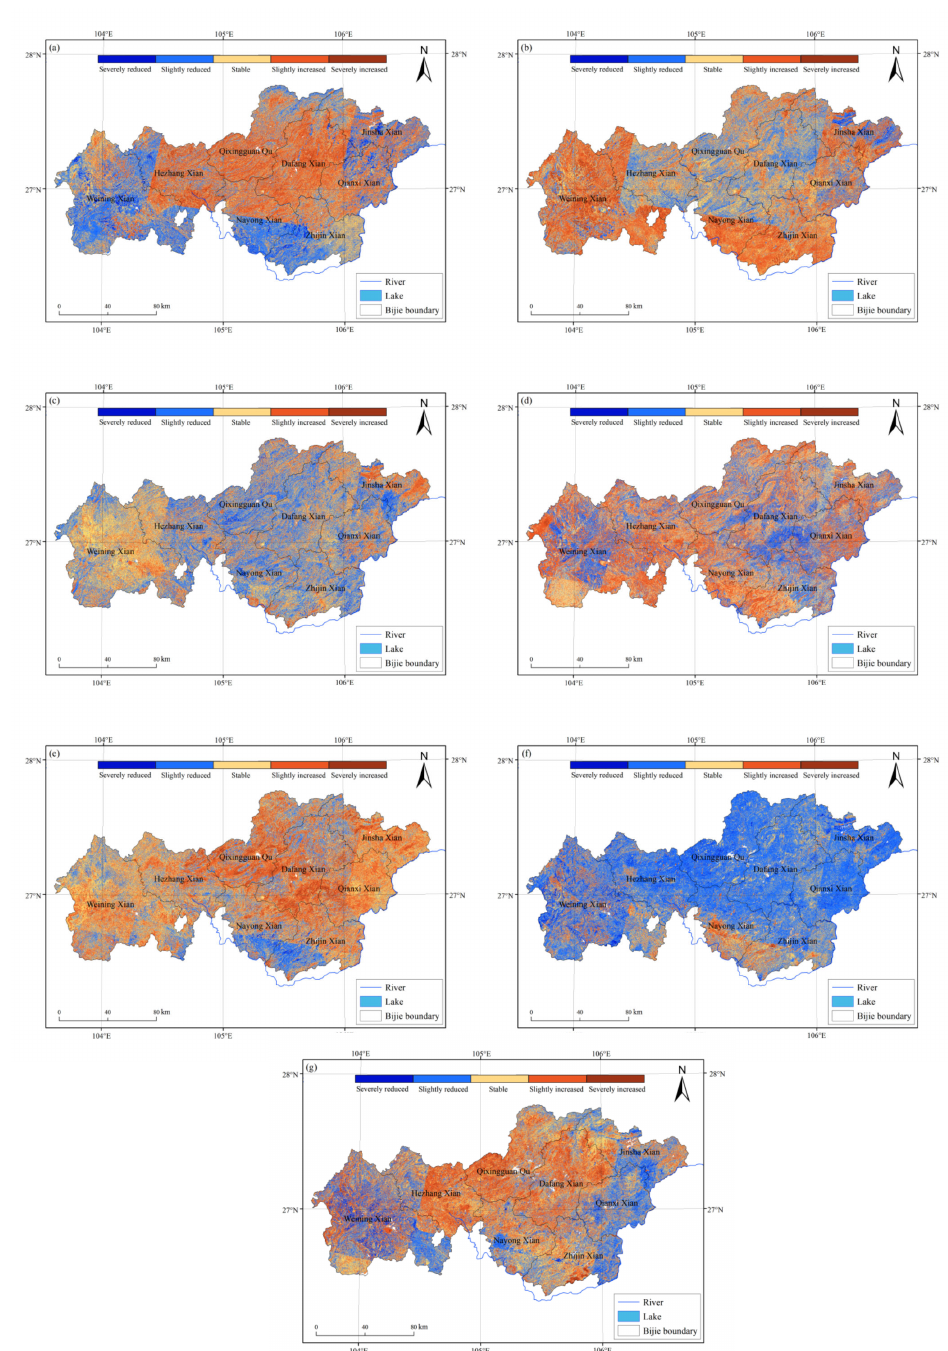
Figure 8. Distribution of levels of rocky desertification change intensity in different historical periods: